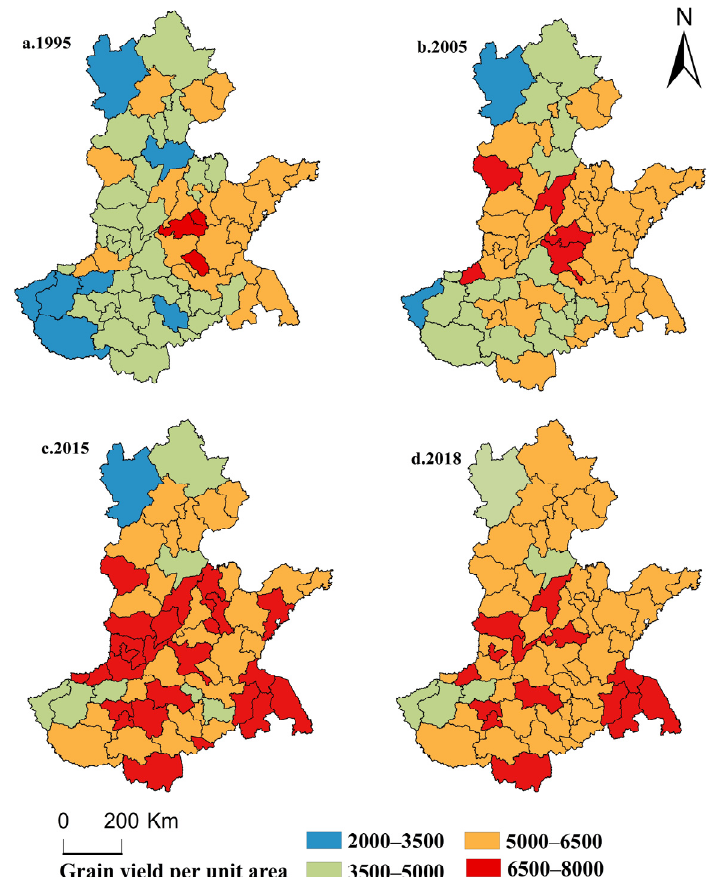
Figure 3. The spatial distribution of grain production in the HHH in ( a ) 1995, ( b ) 2005, ( c ) 2015, and ( d ) 2018 .